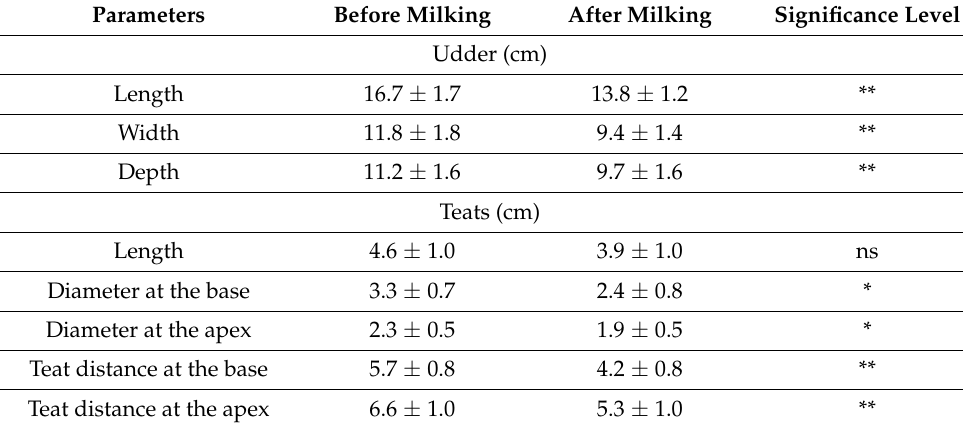
Table 6. Measurement of udder and teat properties before and after machine milking in female donkeys